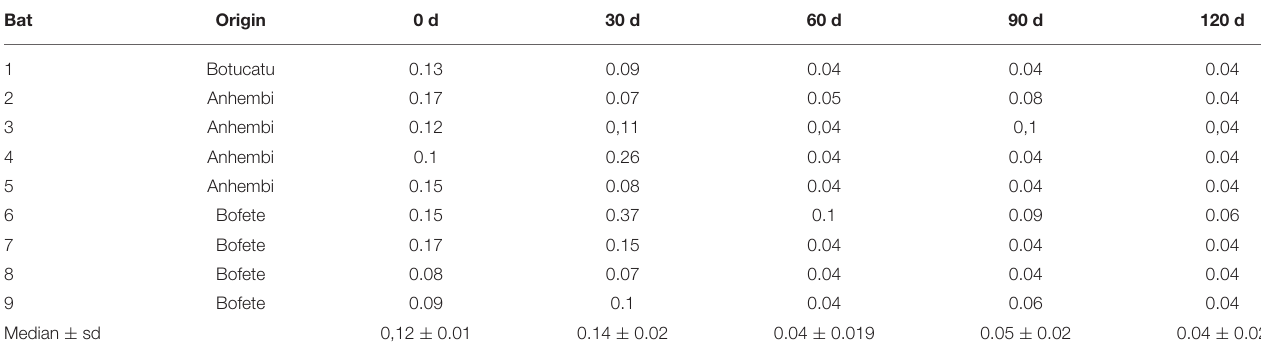
TABLE 2 | Antirabies antibodies titers from bats captured in regions with different epidemiological situation. Bat